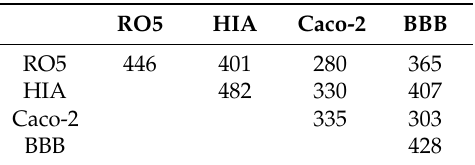
Table 2. The number of phytochemicals which satisfy RO5, HIA, Caco-2 and BBB. We also investigated the number of phytochemicals which satisfy two physiological